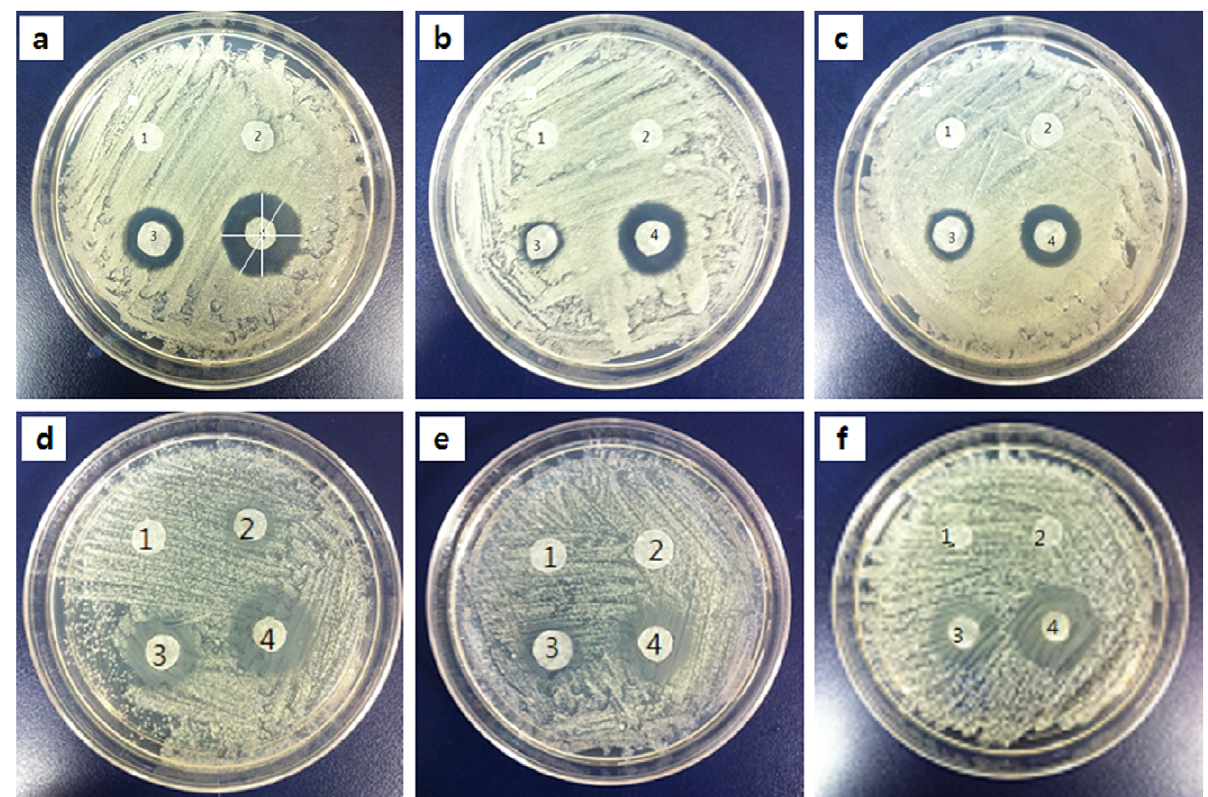
Figure 4. Clearing assays with AmB (a), flucytosine (b), allicin (c), AmB + allicin (d), flucytosine + allicin (e), and AmB + flucytosine + allicin (f). Spot number 1 indicates the control sample. The spots numbered 2, 3, and 4 correspond to antifungal treatments with the concentrations of MIC 10 6 10 2 1 , MIC 10 , and MIC 90 , respectively.